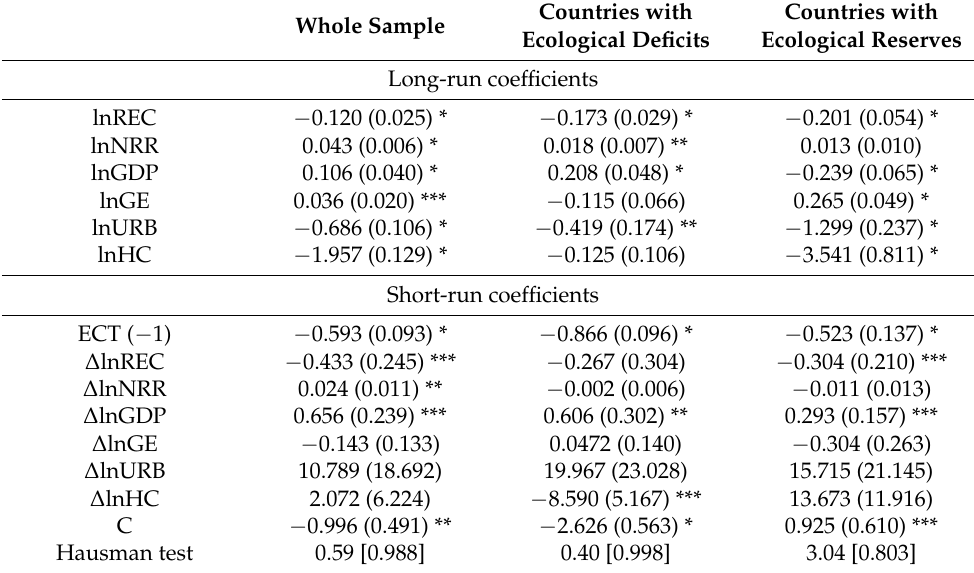
Table 7. PMG ARDL model